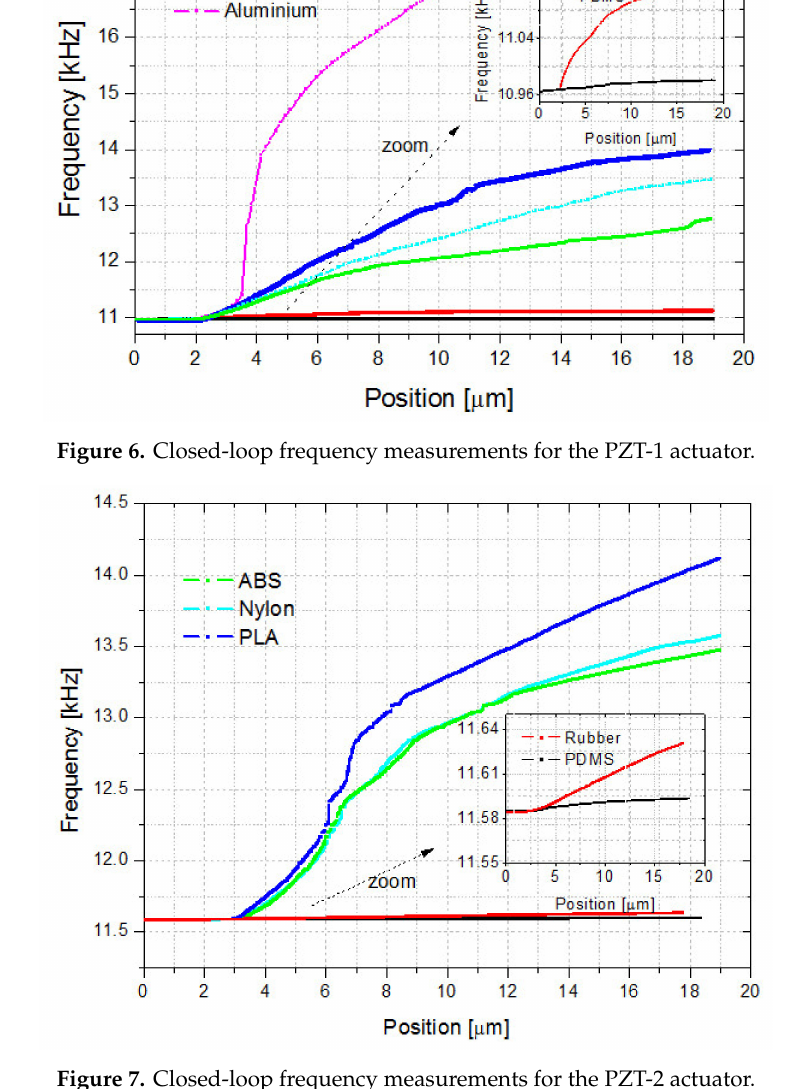
Figure 7. Closed-loop frequency measurements for the PZT-2